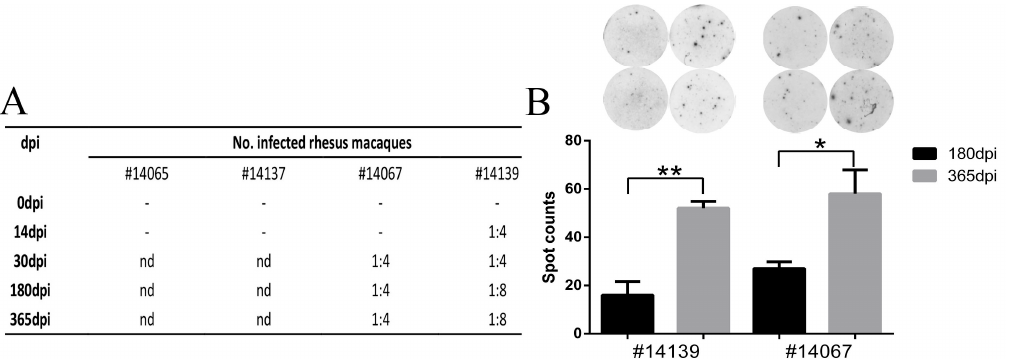
Figure 7. Specific immune responses induced during HSV1 infection in macaques. ( A ) neutralizing antibody testing of serum from macaques No. 14065, No. 14137, No. 14067 and No. 14139. “nd” indicates not detected. No. 14065 and No. 14137 were sacrificed on day 10; and ( B ) ELISpot detection of IFN- γ for specific T cell responses of No. 14067 and No. 14139 on days 180 and 365.“*” indicates p < 0.05, “**” indicates p < 0.01.